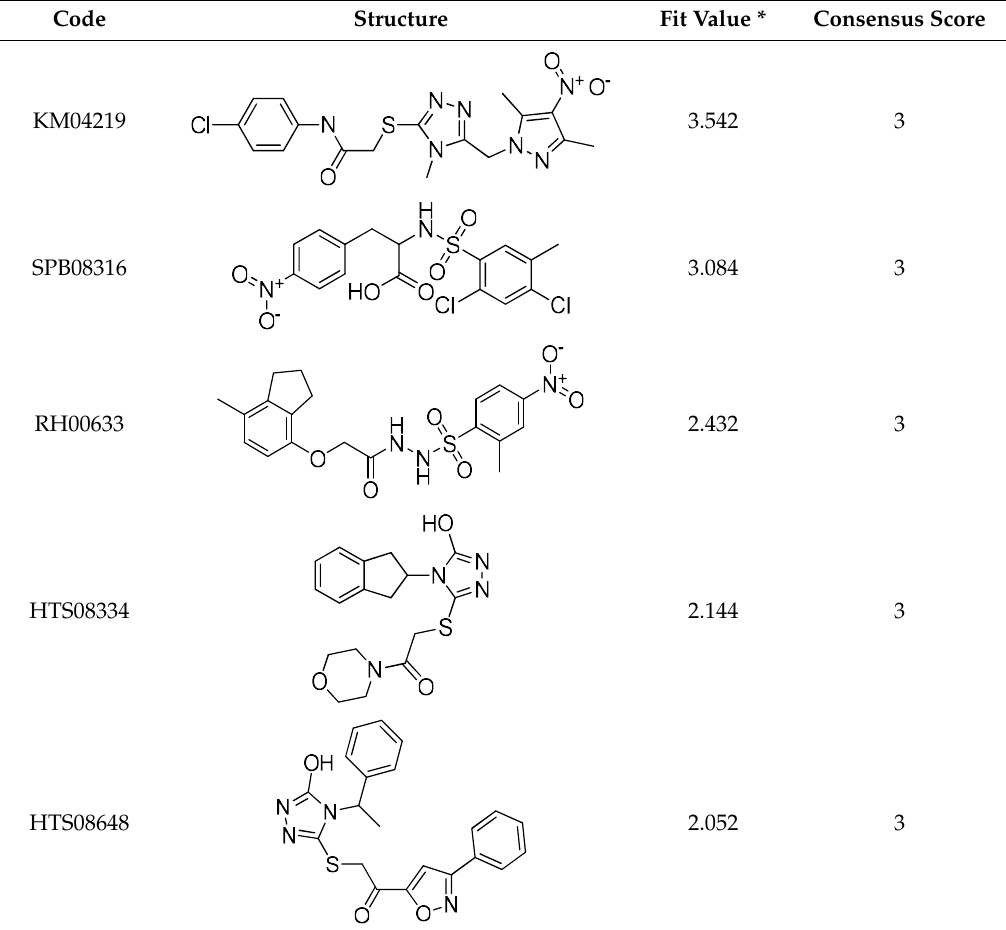
Table 2. Selected hits that are potential inhibitors of the LTA 4 H enzyme.